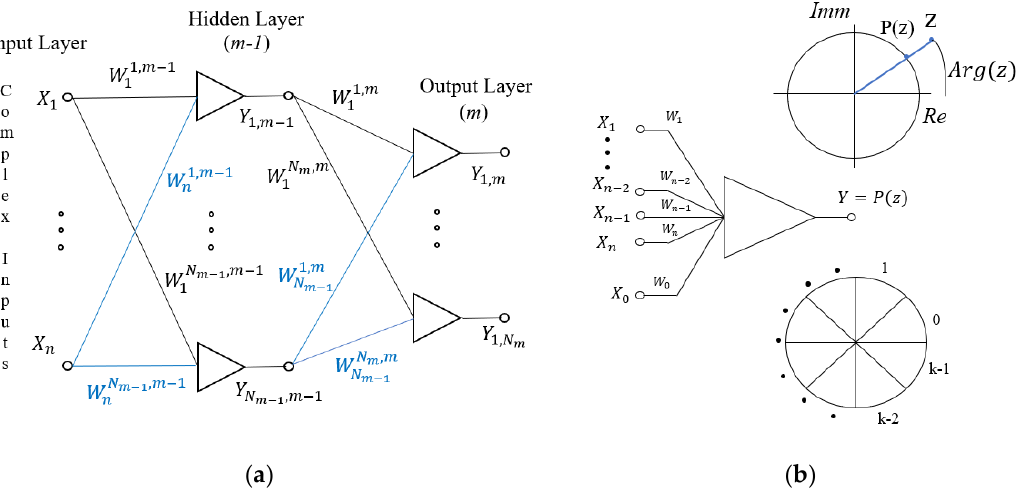
Figure 1. MLMVN: ( a ) global structure of a three − layer neural network; ( b ) multi − valued neuron.